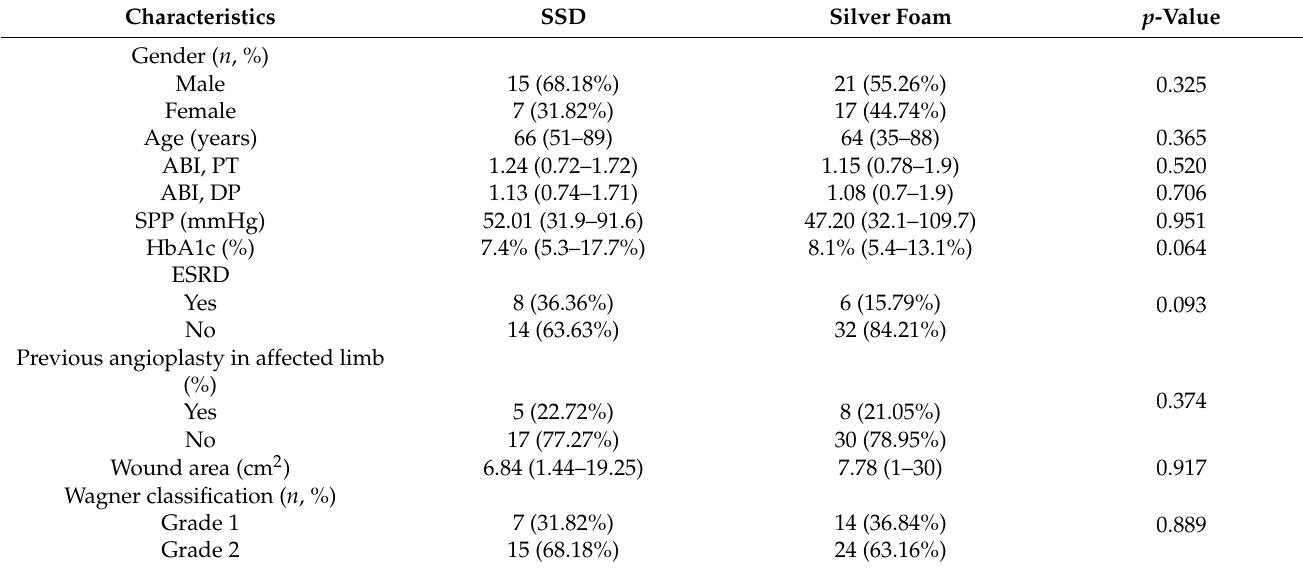
Table 1. Demographic characteristics of the patients between both